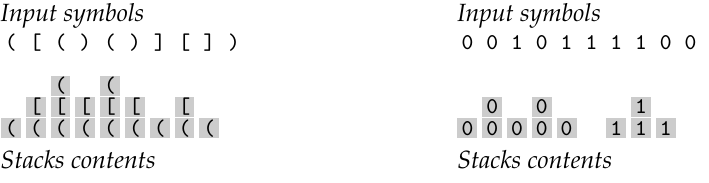
Figure 4. Two examples of the stack contents of two different pushdown automata as they parse the input words “ ([()()][]) ” and “ 0010111100 ”. In ( a ), for each opening parenthesis a push-operation is performed and for each closing parenthesis a pop-operation. In particular, whether or not a push or a pop operation is performed does not depend on the state of the automaton and, hence, the automaton in a visibly pushdown automaton. In contrast, in ( b ), each operation depends not only on the symbol read ( 0 or 1 ), but also on the internal state of the automaton. Indeed, the language accepted by the automaton (decide whether the number of 0 and 1 symbols is equal) cannot be accepted by a visibly pushdown automaton.